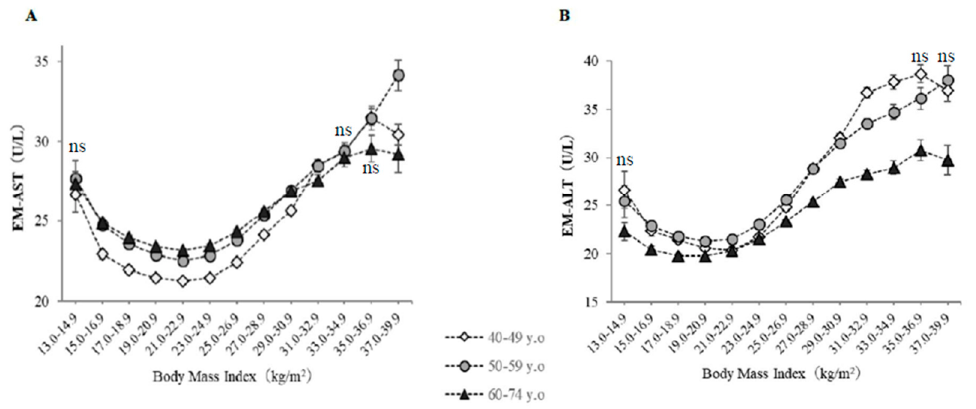
Figure 3. Estimated means of serum AST (EM-AST) and ALT (EM-ALT) activities, classified according to body mass index and age. The symbols indicate the estimated means of AST and ALT activities after controlling for the effects of age, sex, current smoking, daily alcohol intake, habitual exercise, physical activity, pharmacotherapy (for hypertension, diabetes, or dyslipidemia), history of cardiovascular disease, serum triglycerides, high-density lipoprotein cholesterol, GGT, and waist circumference. The vertical bars represent the 95% CIs. ( A ) EM-AST, ( B ) EM-ALT. The BMI categories numbered 1–13 are the same as in Table 1. The numbers of subjects are the same as in Figure 1. The indication of ‘ns’ means no significant difference in values among three age groups in each BMI category. Otherwise, a significant difference was observed (ANOVA).